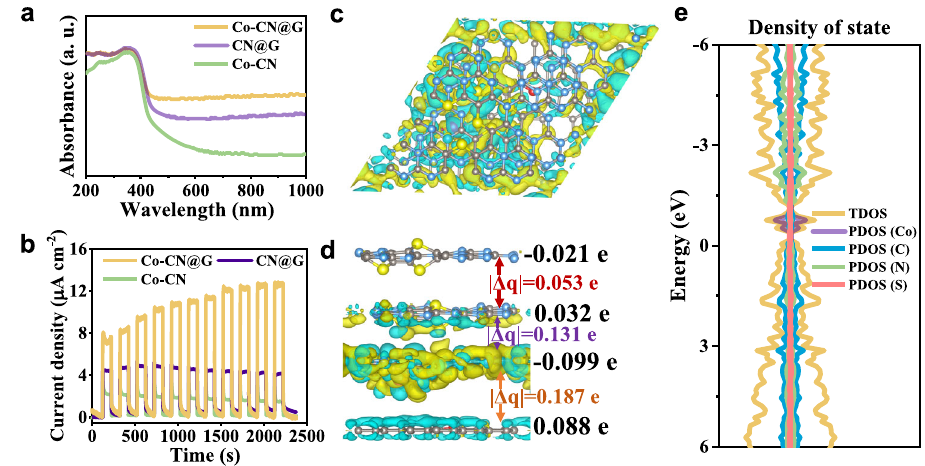
Fig. 2 | Photoelectronic property and electronic structure of Co – CN@G. electrodes. The Mulliken charge difference between each adjacent layer of Co – CN@G for the c enlarged top view and d cross view. Yellow and cyan iso-